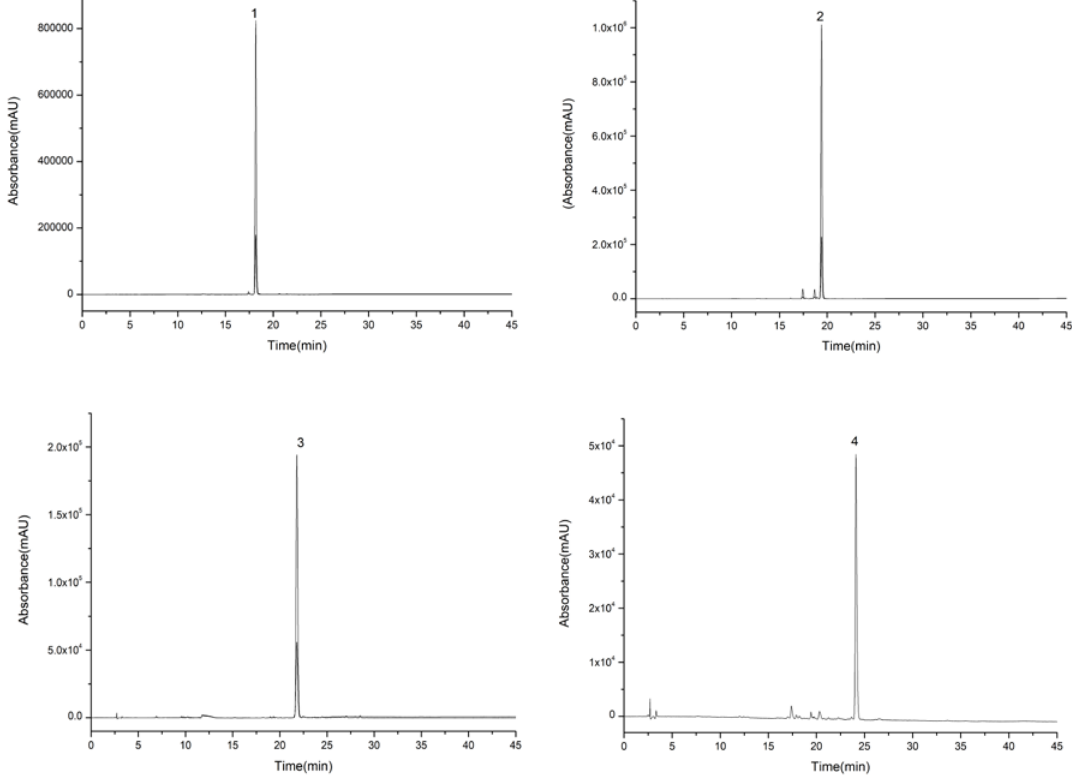
Figure 4. High performance liquid chromatography graphs of compounds ( 1 , 2 , 3 , and 4 ) eluted from extract of 70% ethanol eluent.